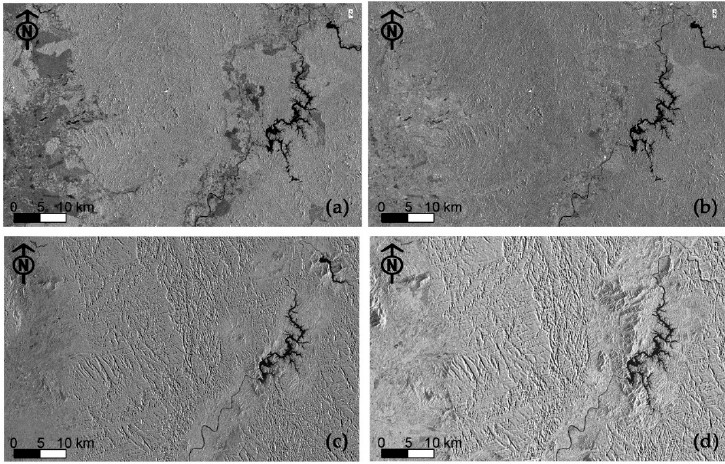
Figure 5. Corrected images for all polarizations of ( a ) PALSAR-2 HV; ( b ) PALSAR-2 HH; ( c ) Sentinel-1A VH; and ( d ) Sentinel-1A VV, displayed in backscatter values.